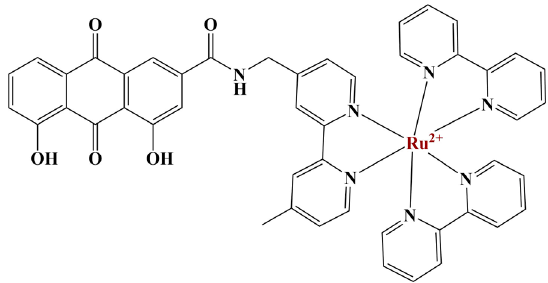
Figure 12. The complex described by [53].